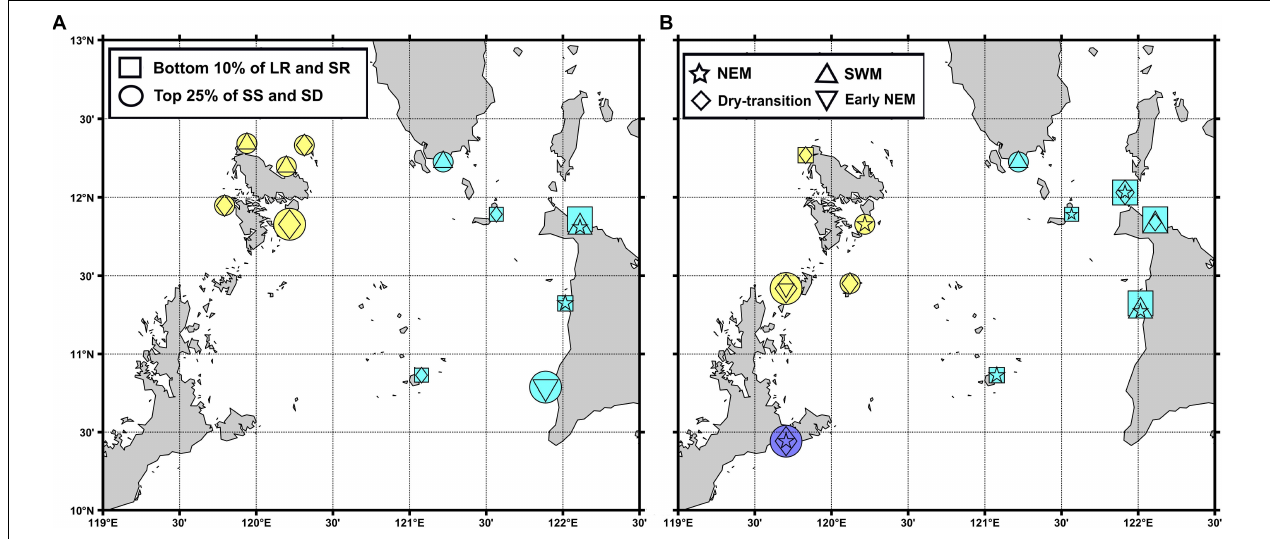
FIGURE 8 | H. scabra (A) and S. horrens (B) locations which belong in the bottom 10% (top 25%) of local retention and self-recruitment (average settlement success and sink diversity index) represented as squares (circles) and colored according to their marine province (Group I purple, Group II cyan, and Group III yellow). Overlaid symbols correspond to the season wherein a location was ranked as such, with some locations top-ranked for 2 seasons. TABLE 2 | Summary of identified priority sites for management of H. scabra and S. horrens populations in the western central Philippines. Metric H. scabra S.